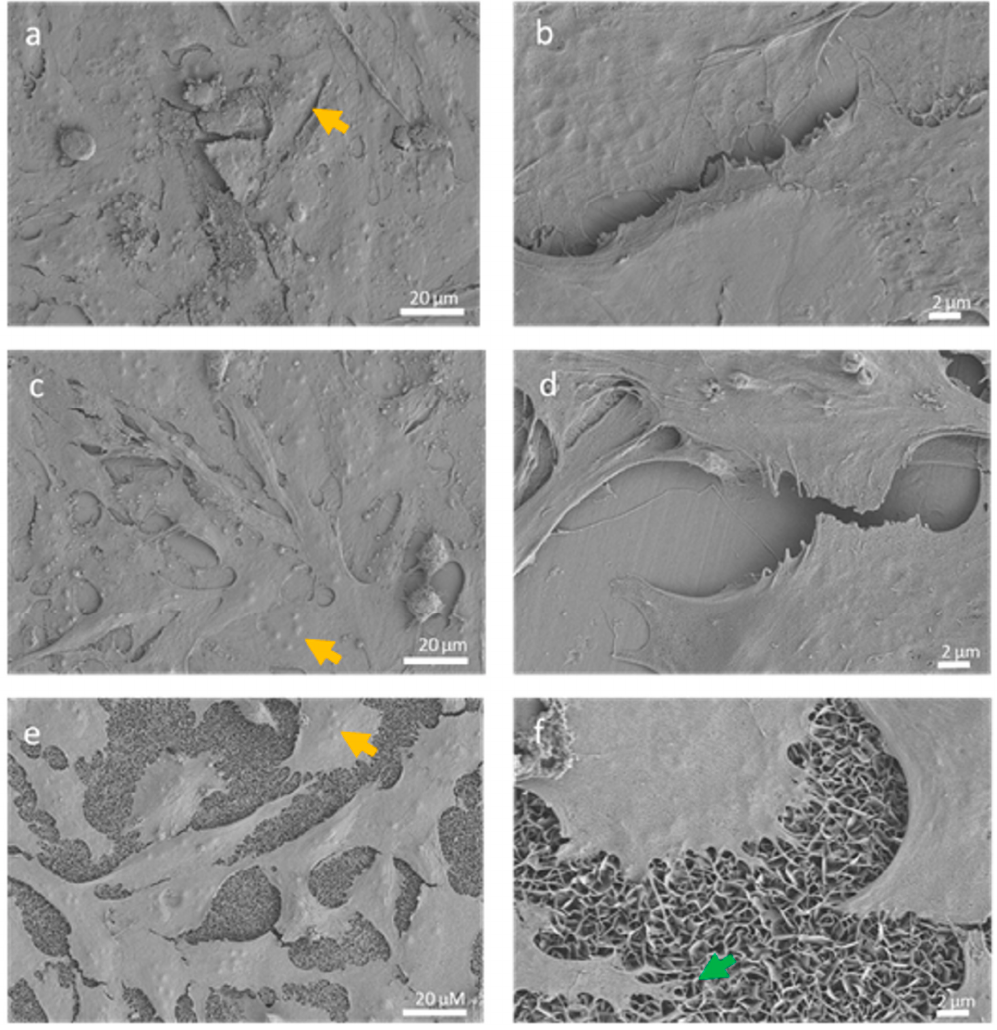
Figure 6. SEM images of Saos-2 cells cultured for 7 days on pristine alloy ( a , b ), ZnO thin film ( c , d ), or ZnO nanosheets ( e , f ). Several nucleoli can be seen inside nuclei (yellow arrows). Long projections are anchored directly on the nanosheets (green arrow).